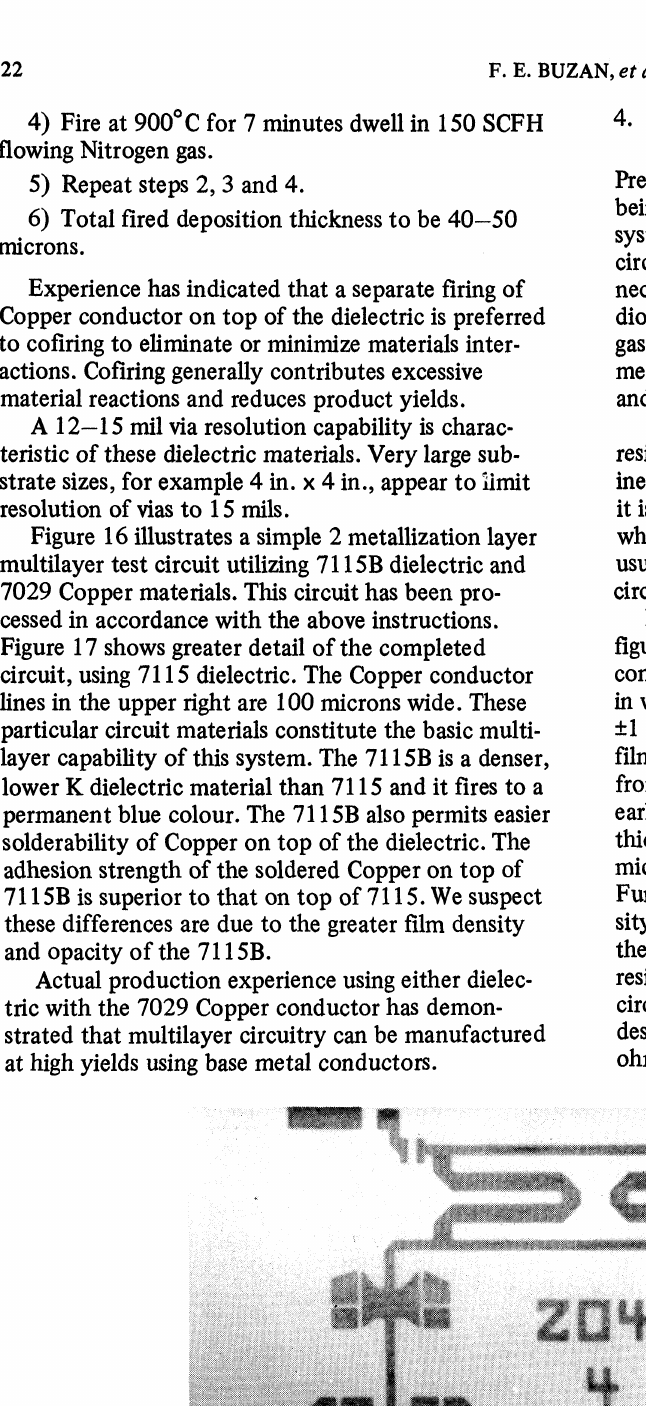
FIGURE 18 Typical strip line circuit configuration (conductor traces 0.62 and 0.25 mm